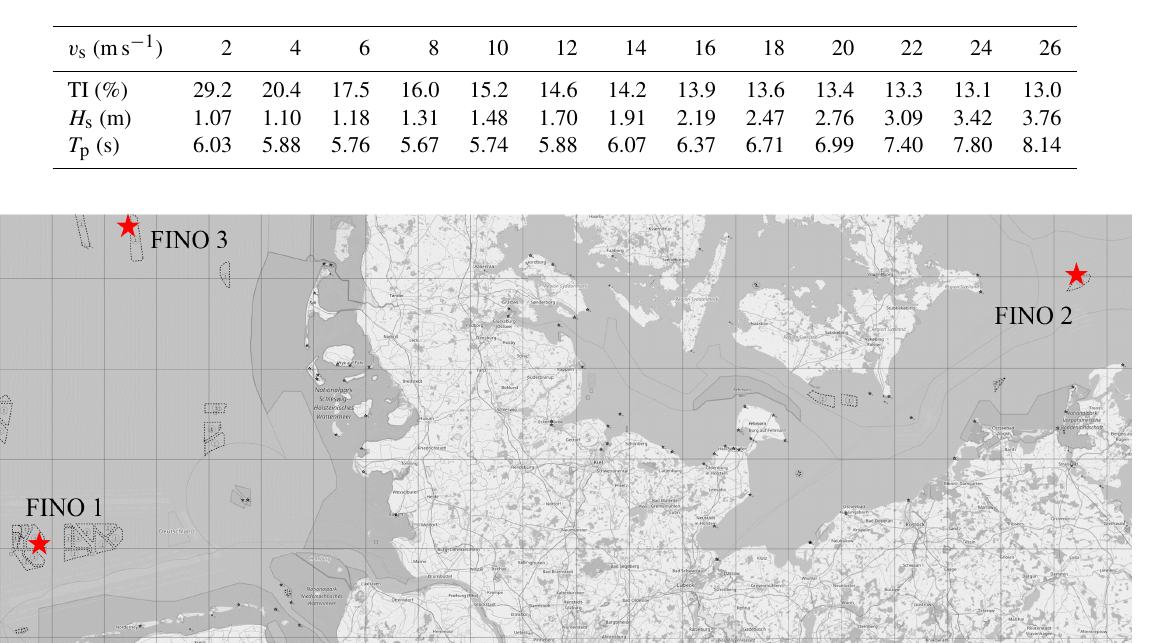
Table 1. Environmental conditions (wind speed v s , significant wave height H s , wave peak period T p , and turbulence intensity TI) of the K13 shallow-water site (U P W IND design basis; Fischer et al., 2010). The wind shear exponent is α = 0 . 14, and wind and wave directions are usually set to zero, but scatter plots are available.